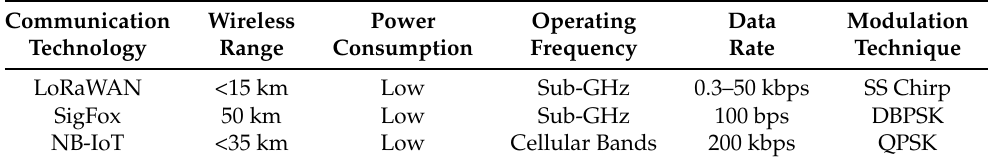
Table 5. Comparison of popular low-power wide-area